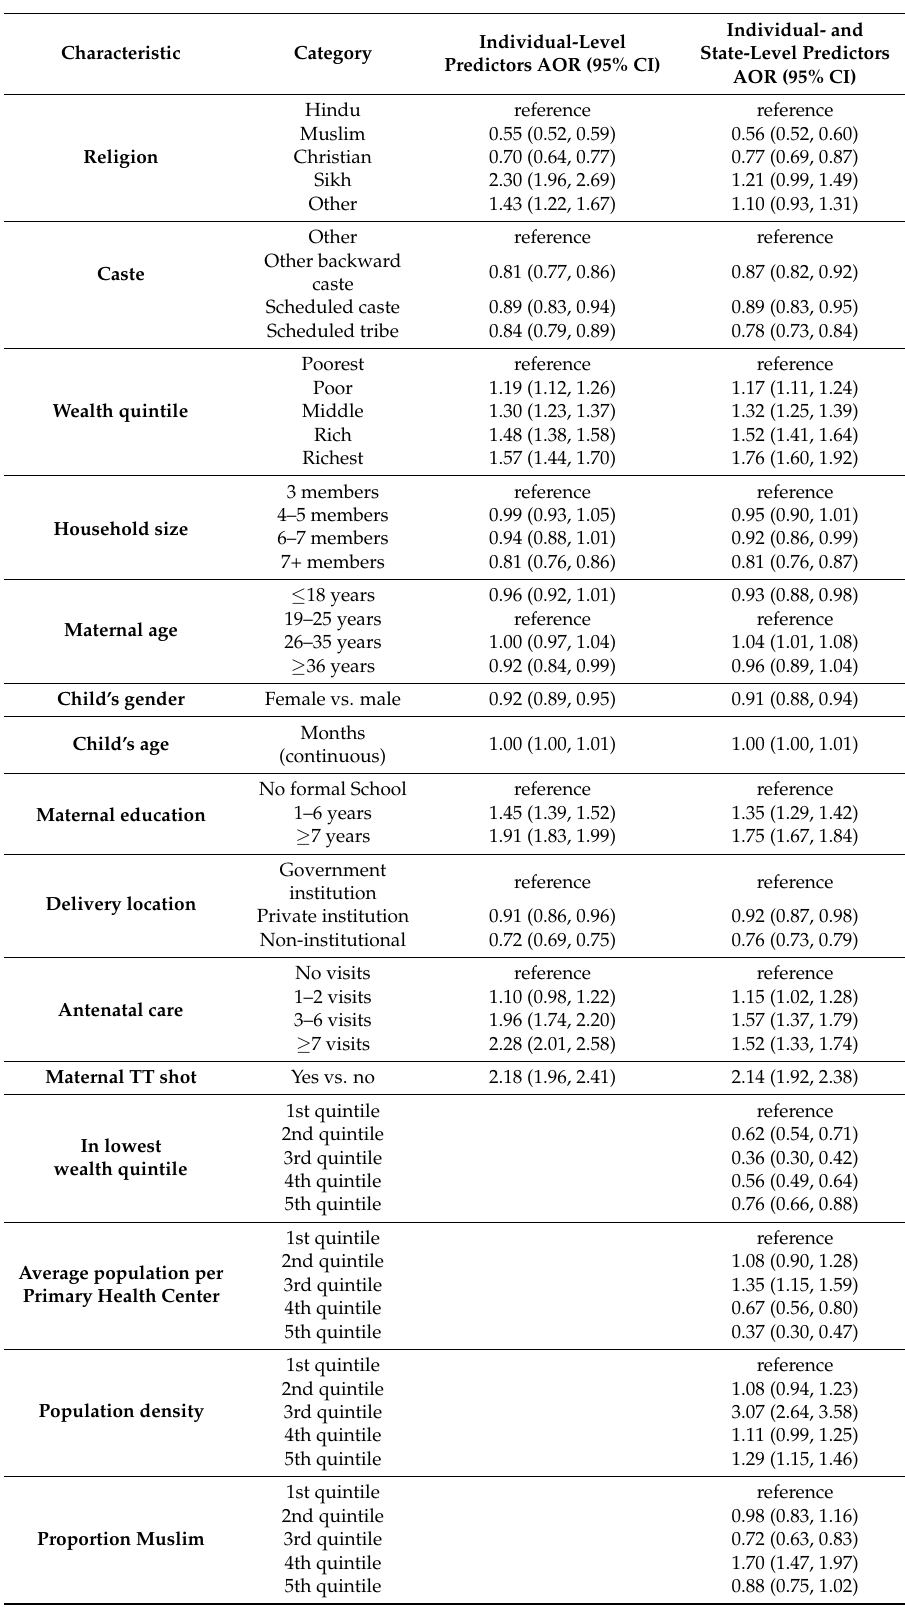
Table 3. Adjusted odds ratios (AOC) and confidence intervals (CI) for full-vaccination of children aged 12 to 36